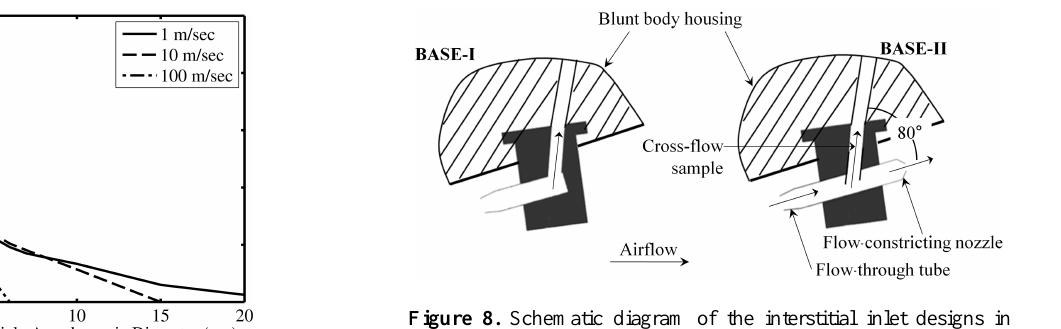
Figure 8. Schematic diagram of the interstitial inlet designs in BASE-I (left) and BASE-II (right).